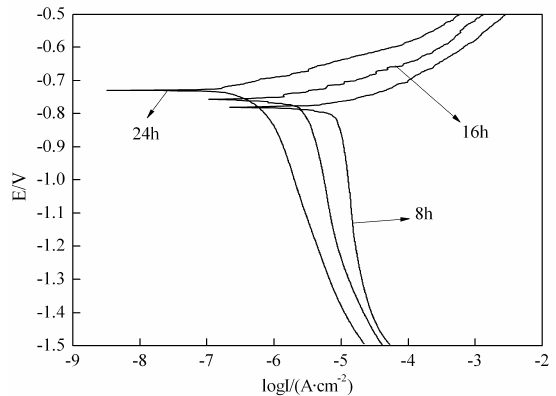
Figure 2. Cathodic polarization curves of 7050 aluminum alloy with different aging time.